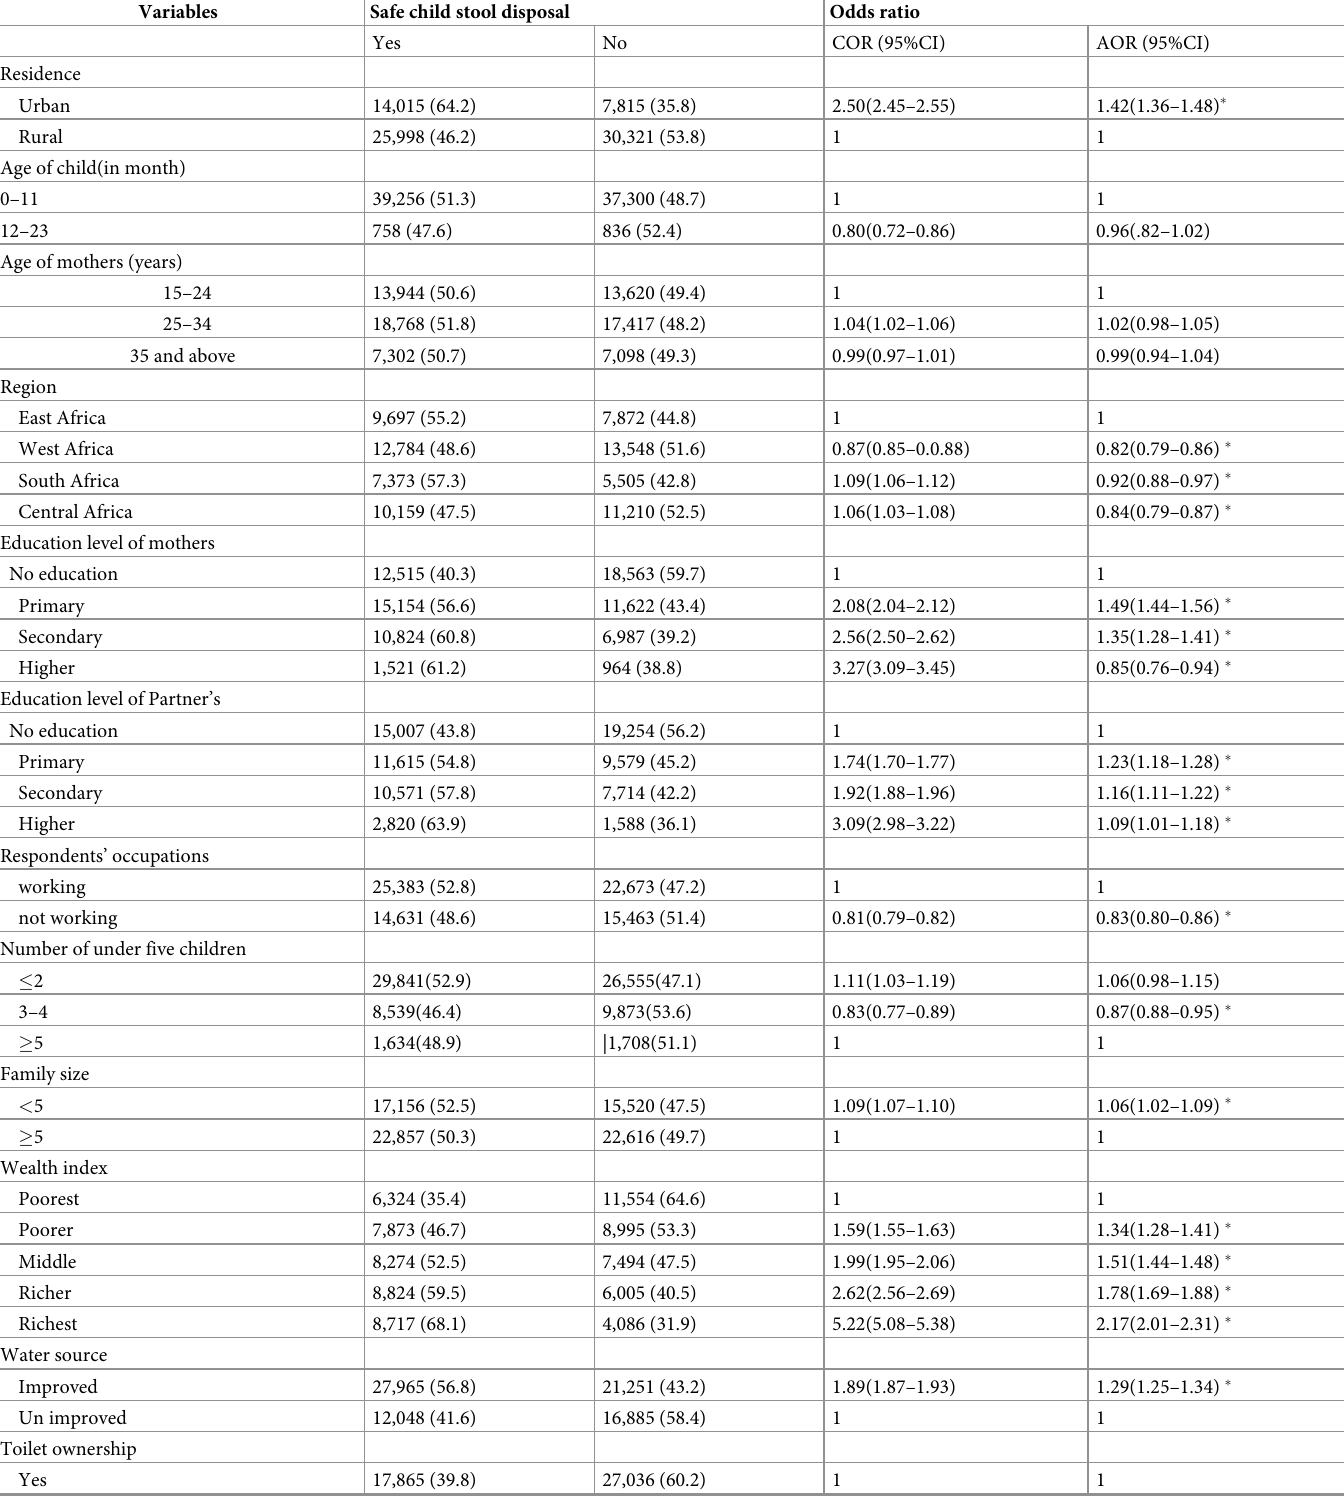
Table 4. Multilevel regression analysis of safe child feces disposal among child < 2 years in sub-Saharan